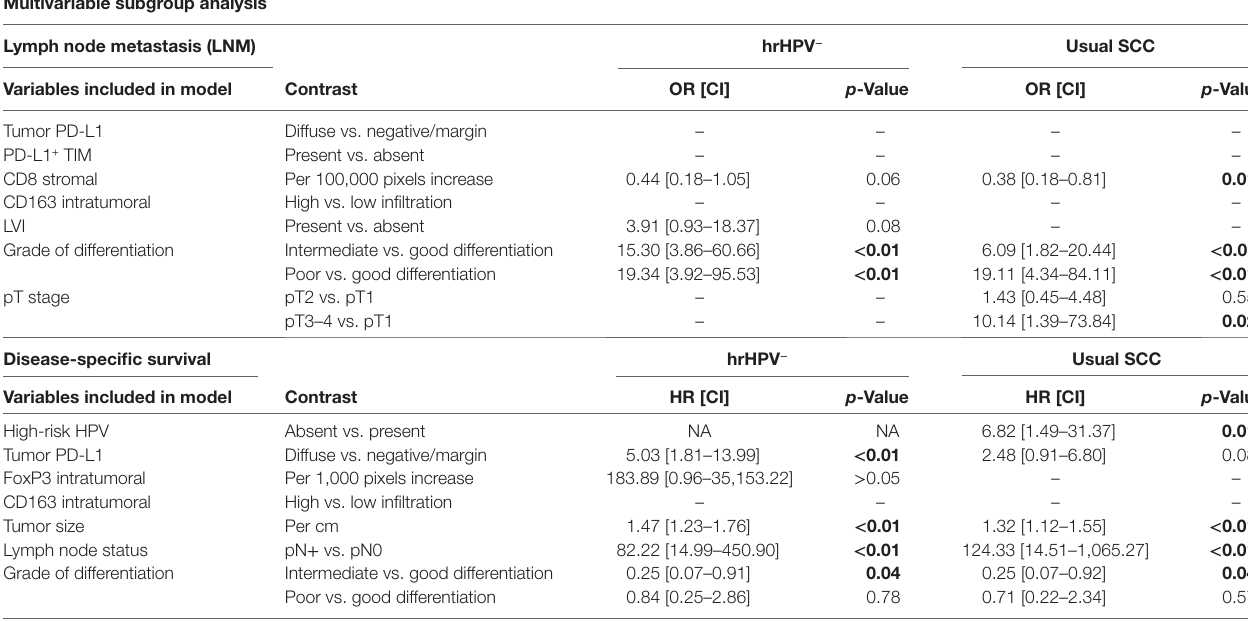
TaBle 5 | Multivariable subgroup analysis. Multivariable subgroup analysis lymph node metastasis